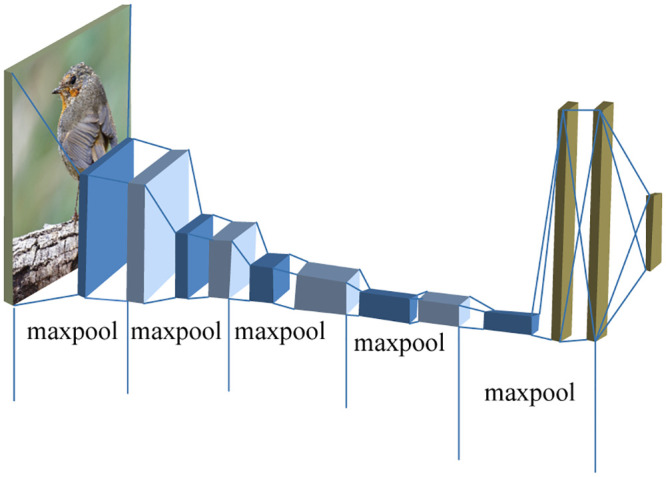
VGG-16 model for bird species classification [36].